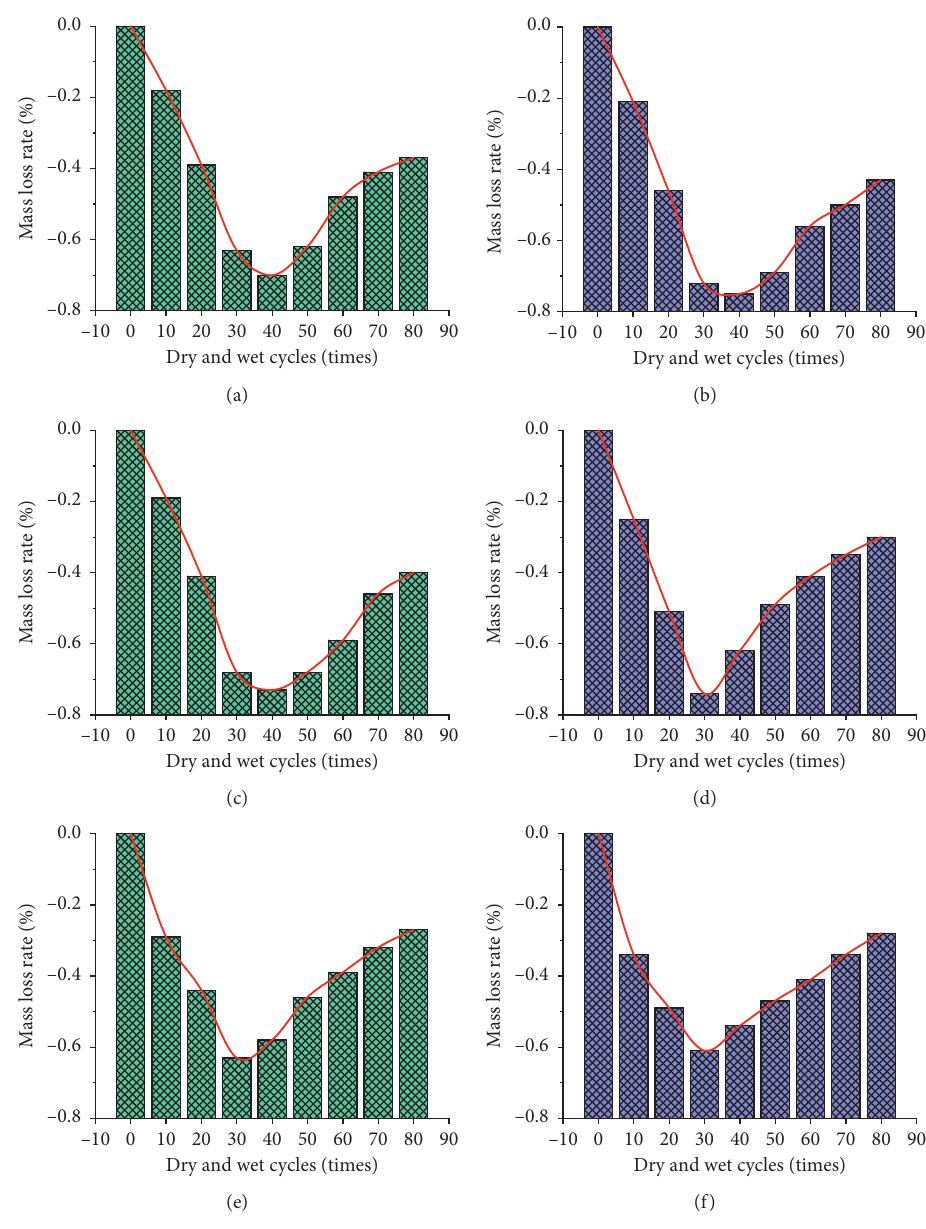
Figure 4: Mass loss rate of recycled concrete. (a) RCA0%–RFA0%. (b) RCA0%–RFA15%. (c) RCA30%–RFA0%. (d) RCA30%–RFA15%. (e) RCA50%–RFA0%. (f)